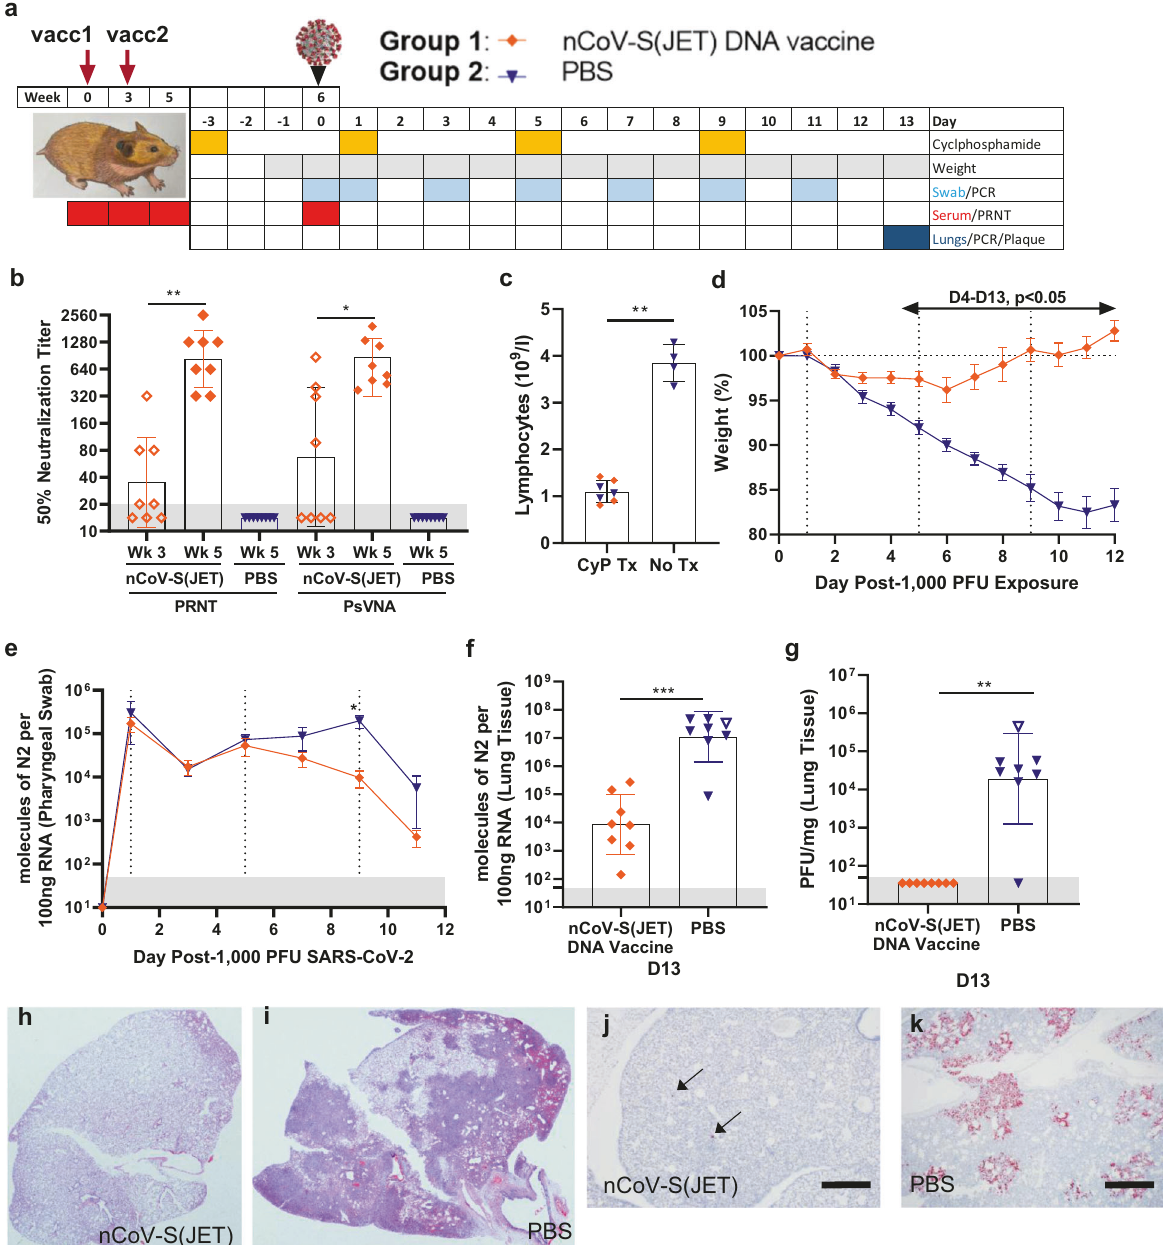
Fig. 2 Evaluation of nCoV-S(JET) DNA vaccine in immunosuppressed Syrian hamsters. a Experimental design. Groups of 8 hamsters each were vaccinated (vacc) with the nCoV-S(JET) DNA vaccine or PBS, immunosuppressed with cyclophosphamide (dashed vertical lines in d and e ), and then challenged with 1,000 PFU of SARS-CoV-2 virus by the intranasal route. b PRNT50 and PsVNA50 titers from serum collected at indicated timepoints after 1 (open symbols) and 2 (closed symbols) vaccinations (assay limit = 20, gray shade). Bars represent GMT ± SD. c Lymphopenia was con fi rmed by hematology. d Average animal weights relative to starting weight. Symbols represent mean ± SEM. Viral RNA in e) pharyngeal swabs and f lung homogenates (assay limit = 50 copies, gray shade). Bars represent GMT ± SD. g Infectious virus as measured by plaque assay (assay limit = 50 PFU, gray shade). Bars represent GMT ± SD. A single animal from the PBS group succumbed on Day 9 post- exposure (open symbol in f and g ). Bright fi eld imagery of H&E staining of lung sections from h nCoV-S(JET) DNA or i PBS vaccinated hamsters where purple indicates areas of consolidation. ISH to detect SARS-CoV-2 genomic RNA in lung sections of j nCoV-S(JET) DNA and k PBS vaccinated hamsters. Rare, positive labeling in nCoV-S(JET) DNA vaccinated hamster lung sections were detected (arrows). Asterisks indicate that results were statistically signi fi cant, as follows: * p < 0.05; ** p < 0.01; *** p < 0.001; ns not signi fi cant. Scale bars = 400 microns. Hamster drawing was provided by Jake Hooper (hjake@vt.edu), with